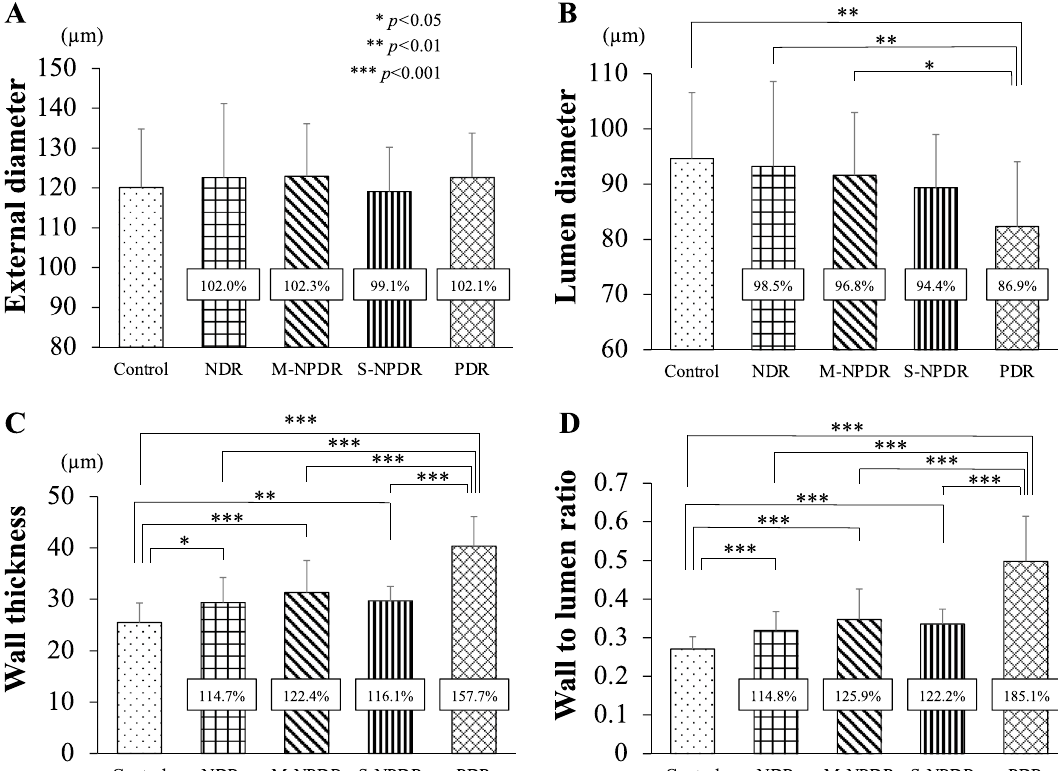
Figure 3. Differences in the changes in the diameter of the retinal vessels determined by AO images among the groups. The percentage change is expressed for the four groups with diabetes, and the values are compared to that of the control group. There were no significant differences in the external diameter among the groups ( A ). The lumen diameter in the PDR group is significantly smaller than in the control, the NDR, and the M-NPDR groups ( B ). The mean wall thickness ( C ) and the mean wall to lumen ratio ( D ) in the control group are significantly lower than in the other groups. The mean wall thickness ( C ) and the mean wall to lumen ratio ( D ) in the PDR groups are significantly larger than in the other groups.